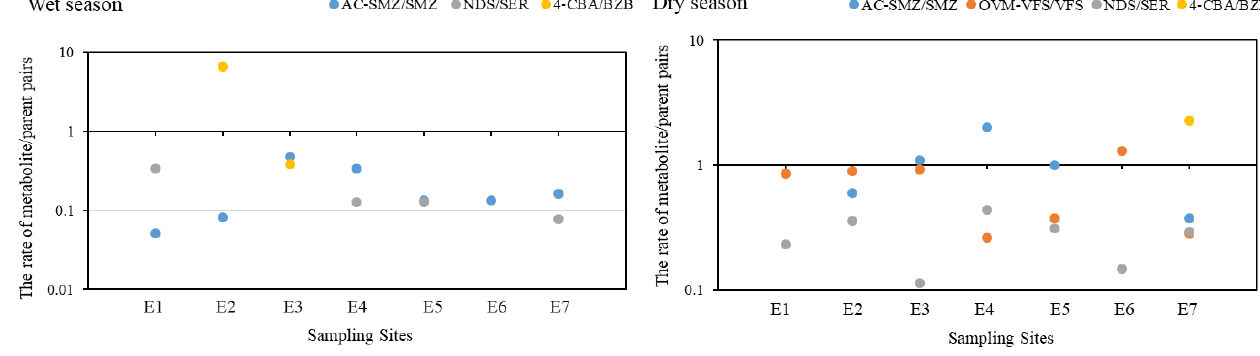
Figure 6. The concentration rates of metabolite/parent pairs in different sites in the sediment of Yunliang river in the wet and dry